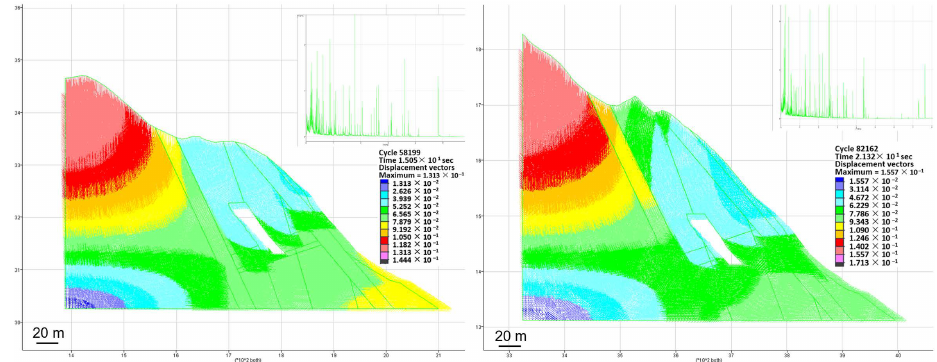
Figure 11. Model S1 ( left ) and model S2 ( right ) reaching the equilibrium